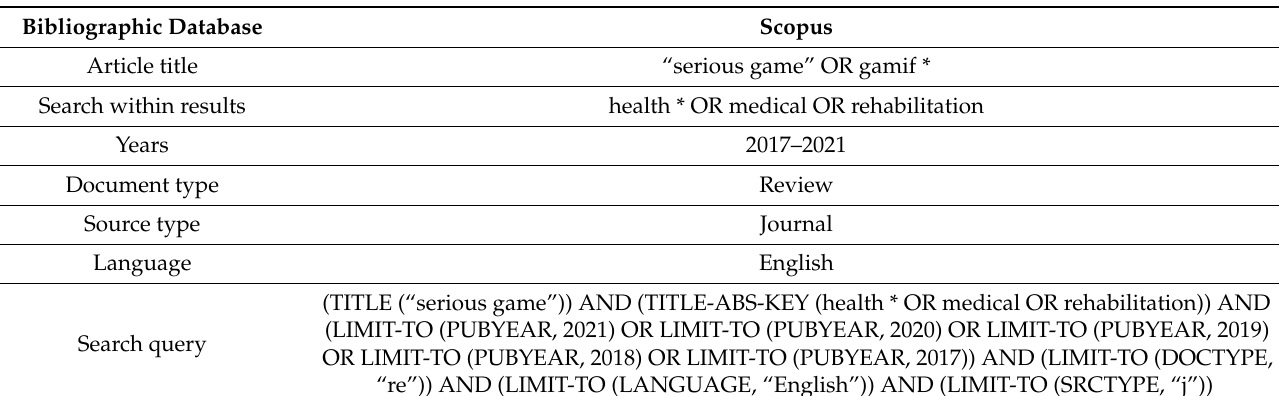
Table 1. Summary of the